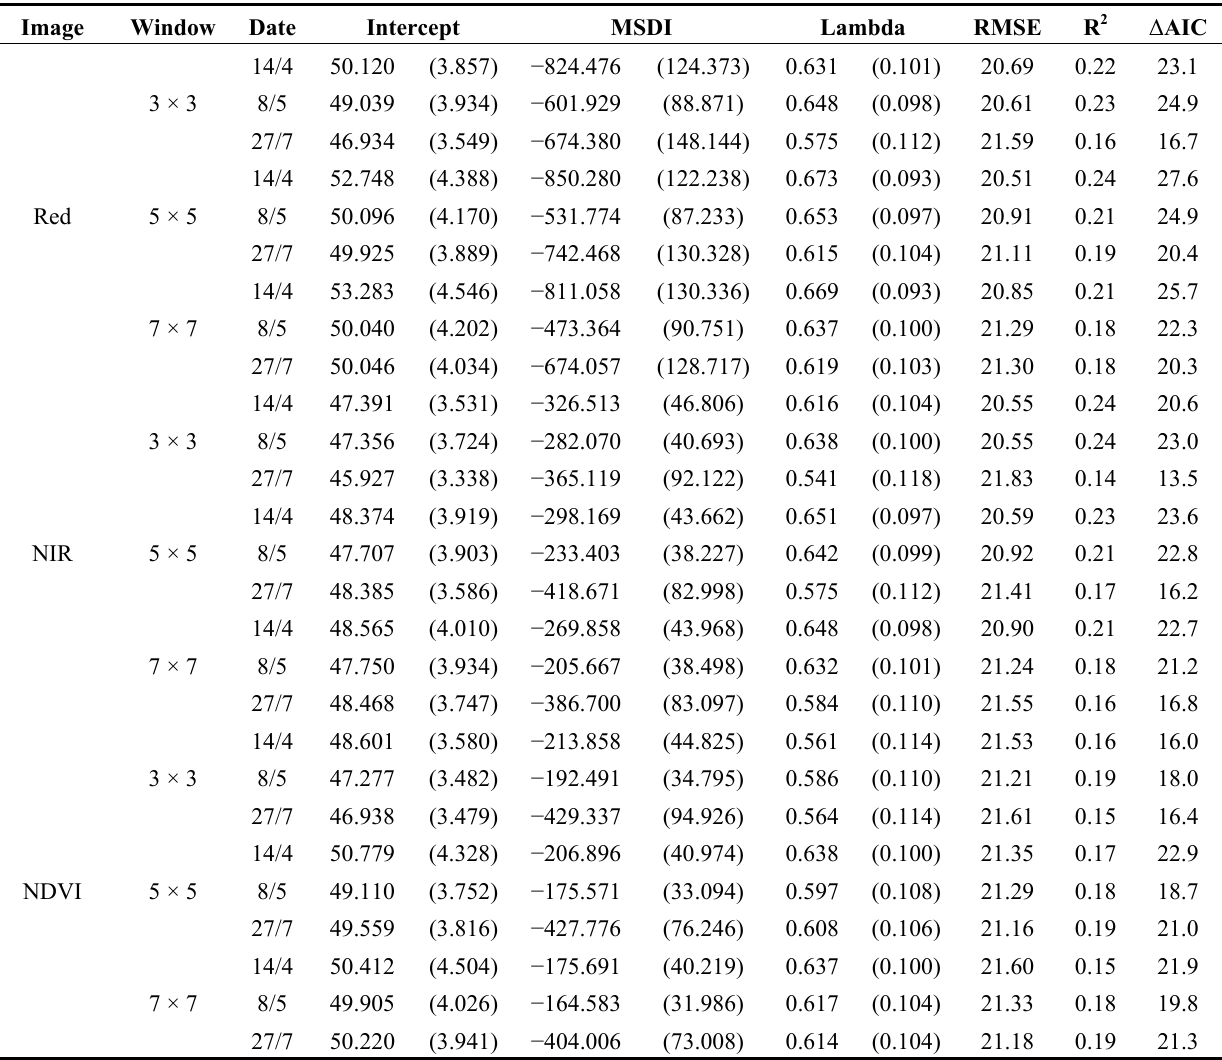
Table 1. Spatial regression results for weighted elephant utilization in the riverfront region of Chobe National Park, Botswana. See Equation (5) in the text for spatial error simultaneous autoregressive model formulation. Values in parentheses indicate standard error estimates for regression parameters. All estimates have p < 0.005 (n = 257 for all models). All dates are in